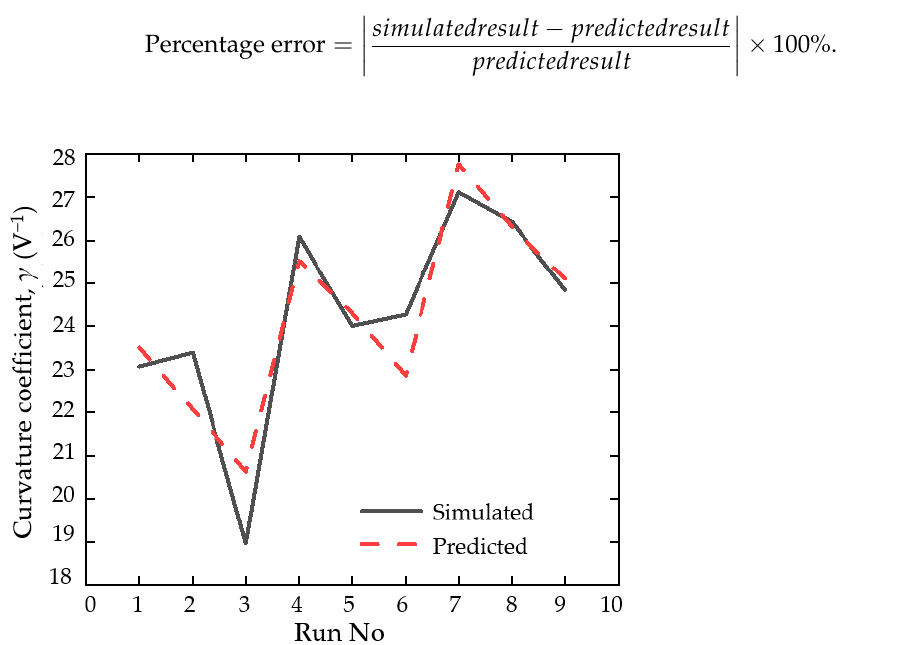
Figure 7. Comparison between predicted and simulated results for curvature coefficient peak, γ peak.